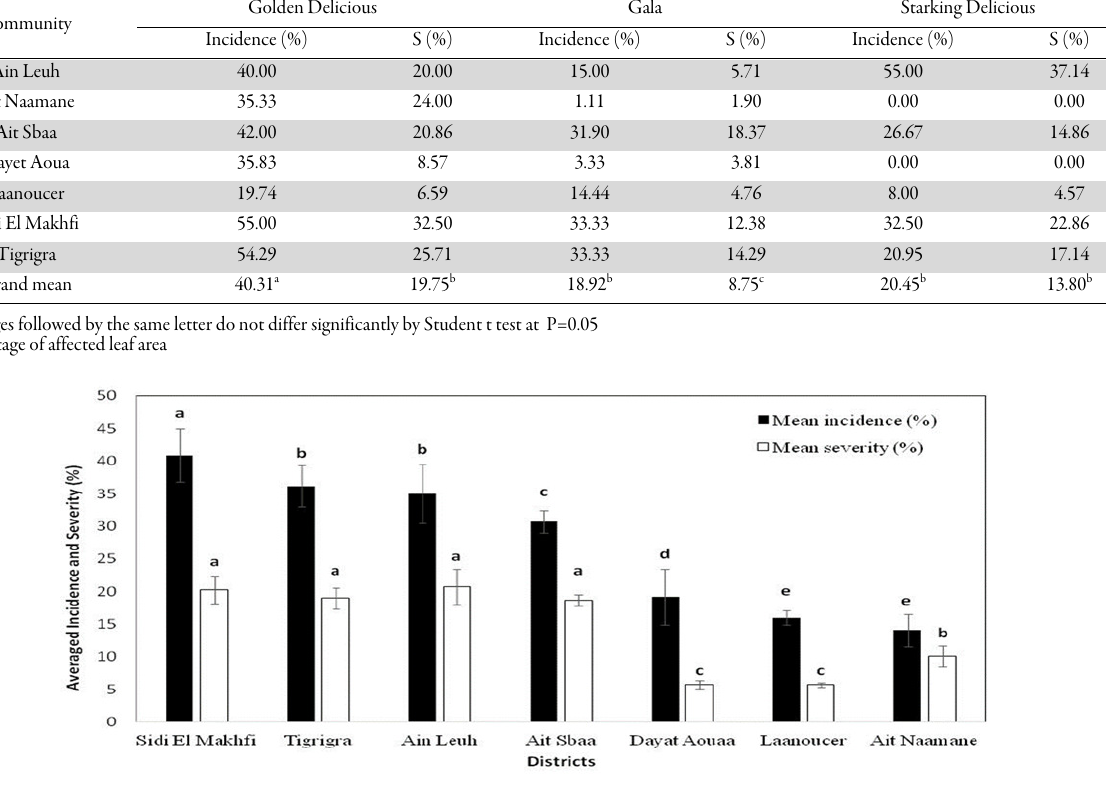
Fig. 2. Mean incidence and severity of apple scab in the different districts of the Sais region. Values marked with the same letter(s) are not statistically different (P ≤